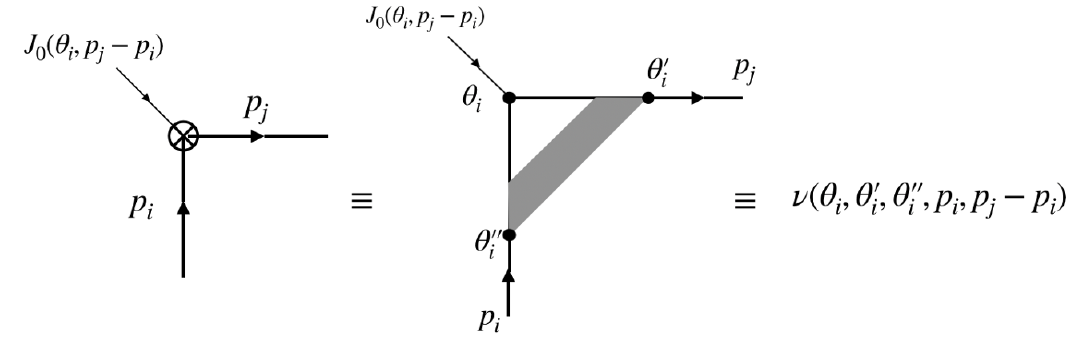
Figure 8 . Convention for the de(cid:12)nition of each vertex in the 4-point function. The ‘internal’ Grassmann variables, (cid:18) 0 ; (cid:18) 00 that are explicitly shown here are suppressed in (cid:12)gure 9 to avoid clutter. i i These internal variables are integrated over in the computation of the correlation functions. The convention of various momenta entering or leaving the vertex is also demonstrated